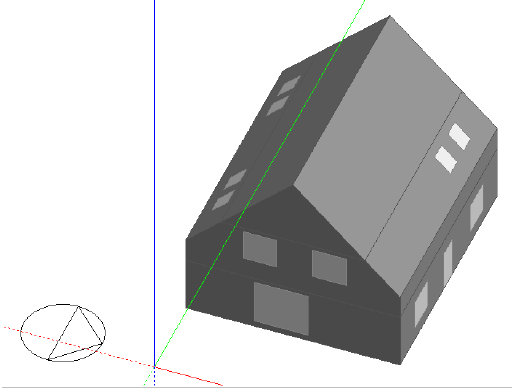
Figure 2. Visualization of the tested single-family house made in the DesignBuilder software (own elaboration).